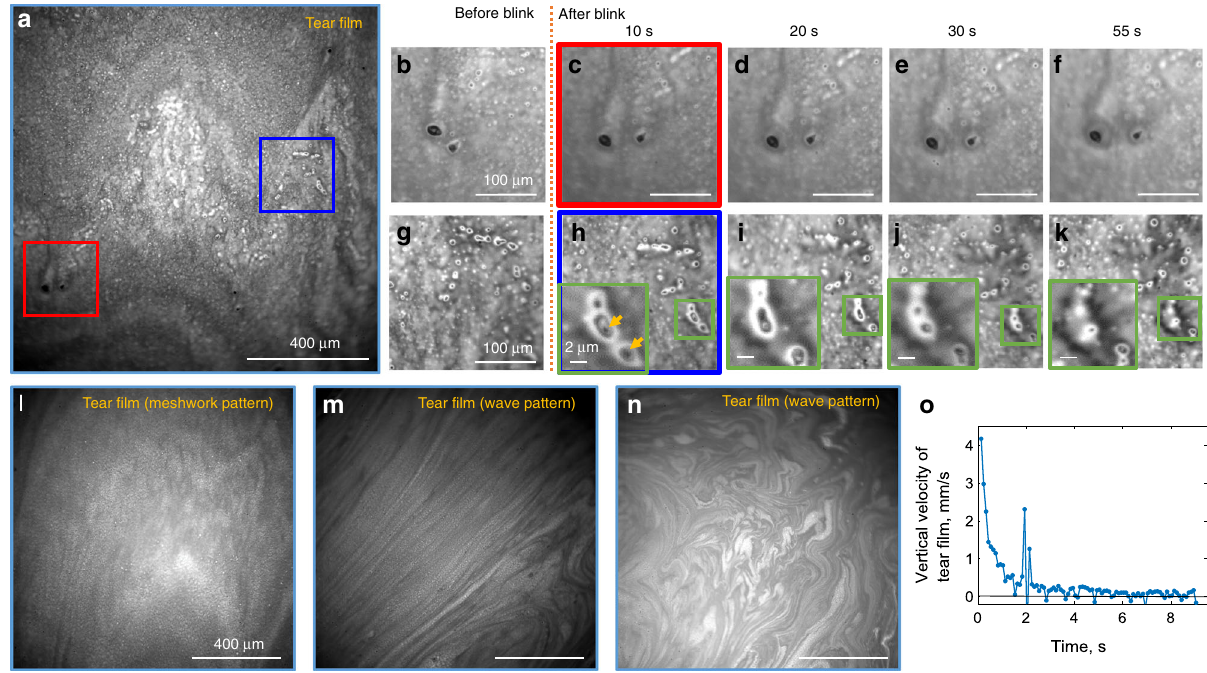
Fig. 7 Imaging human tear fi lm in vivo with conventional microscope con fi guration of FF/SD OCT. a , l – n Single frame direct re fl ection images from the tear fi lm. Interference patterns form the tear lipid layer can be used to evaluate its thickness. b – f , g – k Zoomed images from the real-time blink movie (Supplementary Movie 10). Isolated particulate matter, thought to be cellular debris or accumulations of newly secreted lipid from the Meibomian glands, were found in all subjects. Particles were static, changing locations only from blink to blink together with the movement of the tear fi lm. Green zoomed images show liquid drops surrounding small particles. Liquid was evaporating over time. o Vertical velocity of the tear fi lm, measured by manually tracking movements of particles in the movie. Tear fi lm stabilized after 9 s following the blink. Peak at 2 s corresponds to saccadic eye motion. The source data underlying the plot in o are provided as a Source Data fi le. All unlabeled scale bars 400 µ m. Experiments were reproduced several times in each of the three healthy